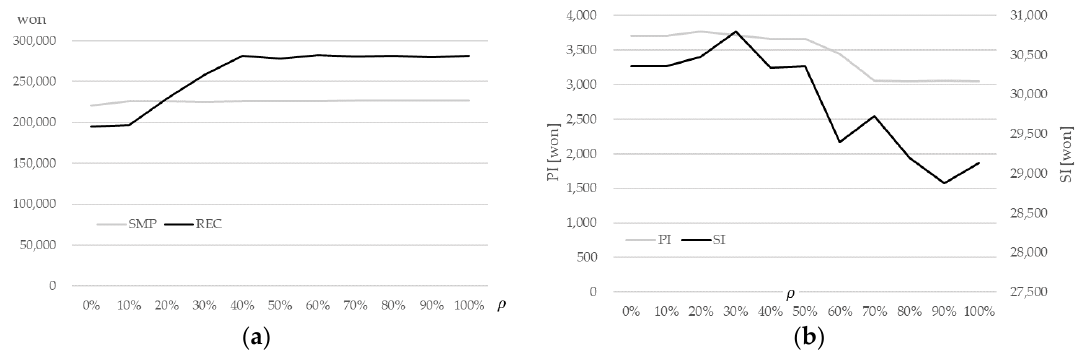
Figure 13. Change in ( a ) SMP and REC, and ( b ) PI and SI subject to the value of 𝜌 𝑗 and 𝜌 𝑘 .